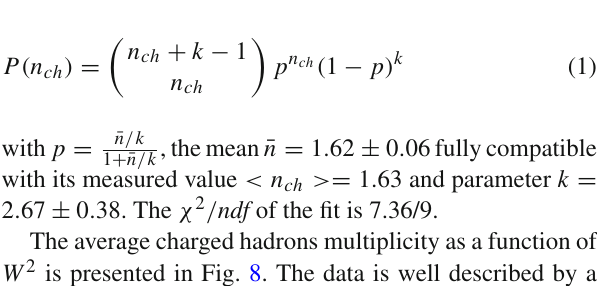
Fig. 8 Theaveragechargedhadronmultiplicitydistributionsasafunc- tion of lnW 2